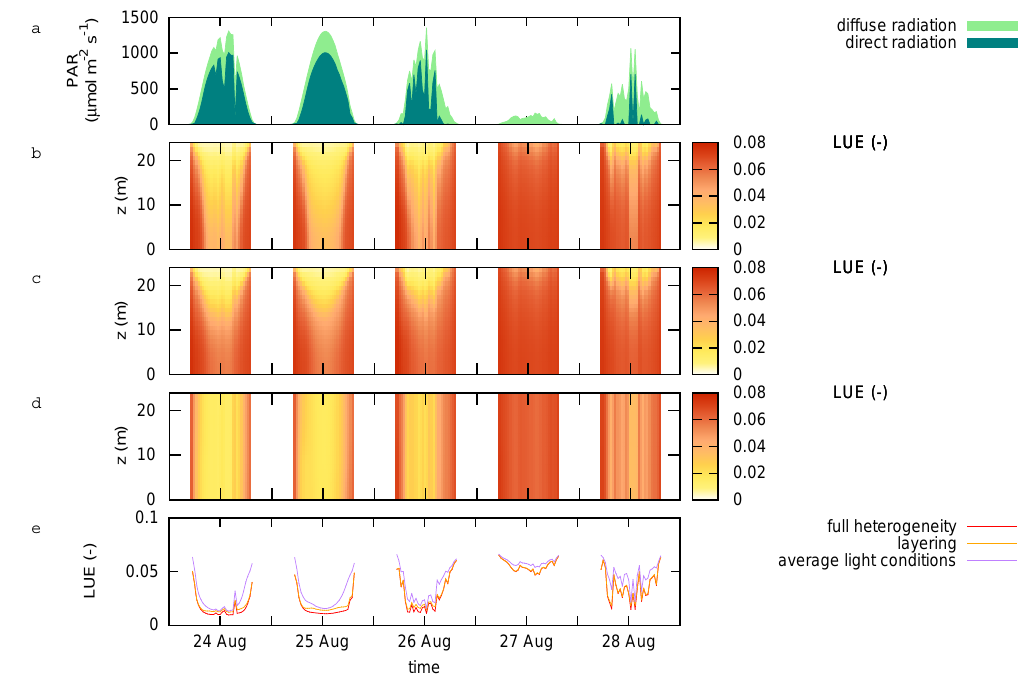
Figure 6. Light conditions and their distribution in the canopy for the case period 24 to 28 August 1999: (a) above-canopy photosynthetically active radiation (PAR, separated into direct and diffuse components); (b) light use efficiency (LUE, CO 2 assimilation per unit of absorbed PAR) for the full heterogeneity case (simulation HET); (c) light use efficiency for a set-up that does not separate sunlit and shaded leaves (simulation HOM_PAR_LAYER); (d) light use efficiency for a set-up that separates neither sunlit and shaded leaves, nor layers (simulation HOM_PAR); (e) canopy-scale light use efficiency (CO 2 assimilation per unit of incoming